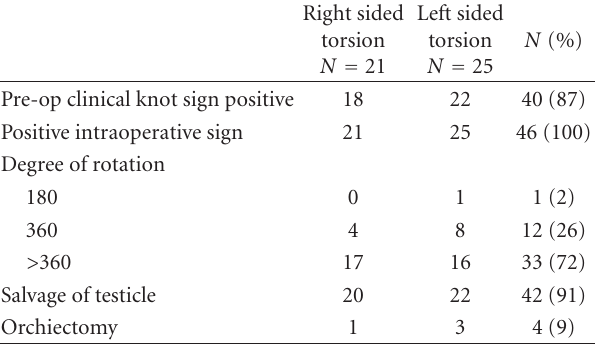
Table 2: Clinical and operative findings of patients with spermatic cord